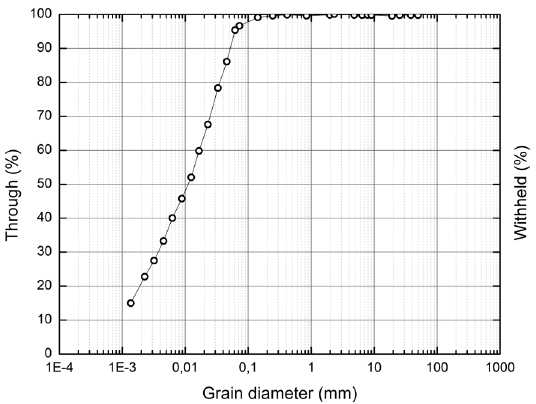
Figure 2. Marble residues granulometric curve